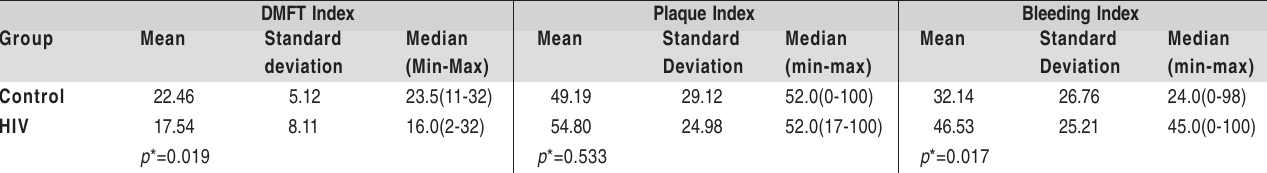
Table 2 - Mean, standard deviation, median and descriptive p level for dmft index, plaque index and bleeding index